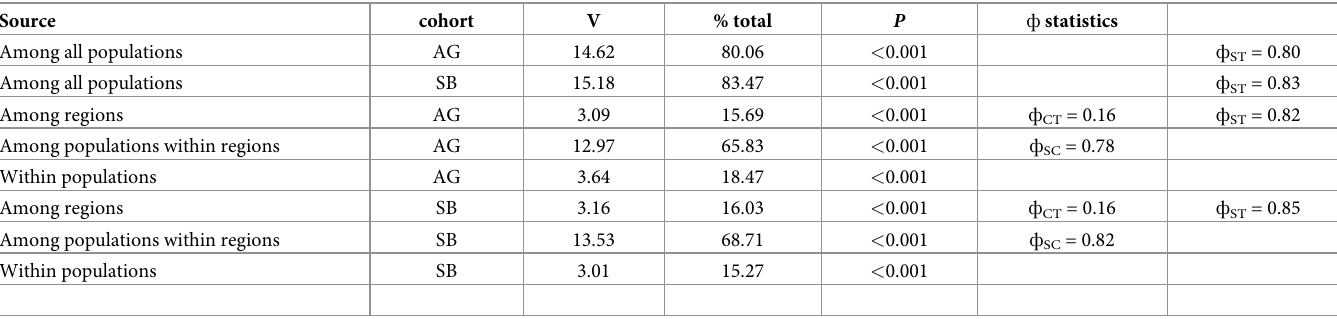
Table 3. Summary of hierarchical AMOVA results for aboveground and seed bank cohorts of the surveyed Viola elatior